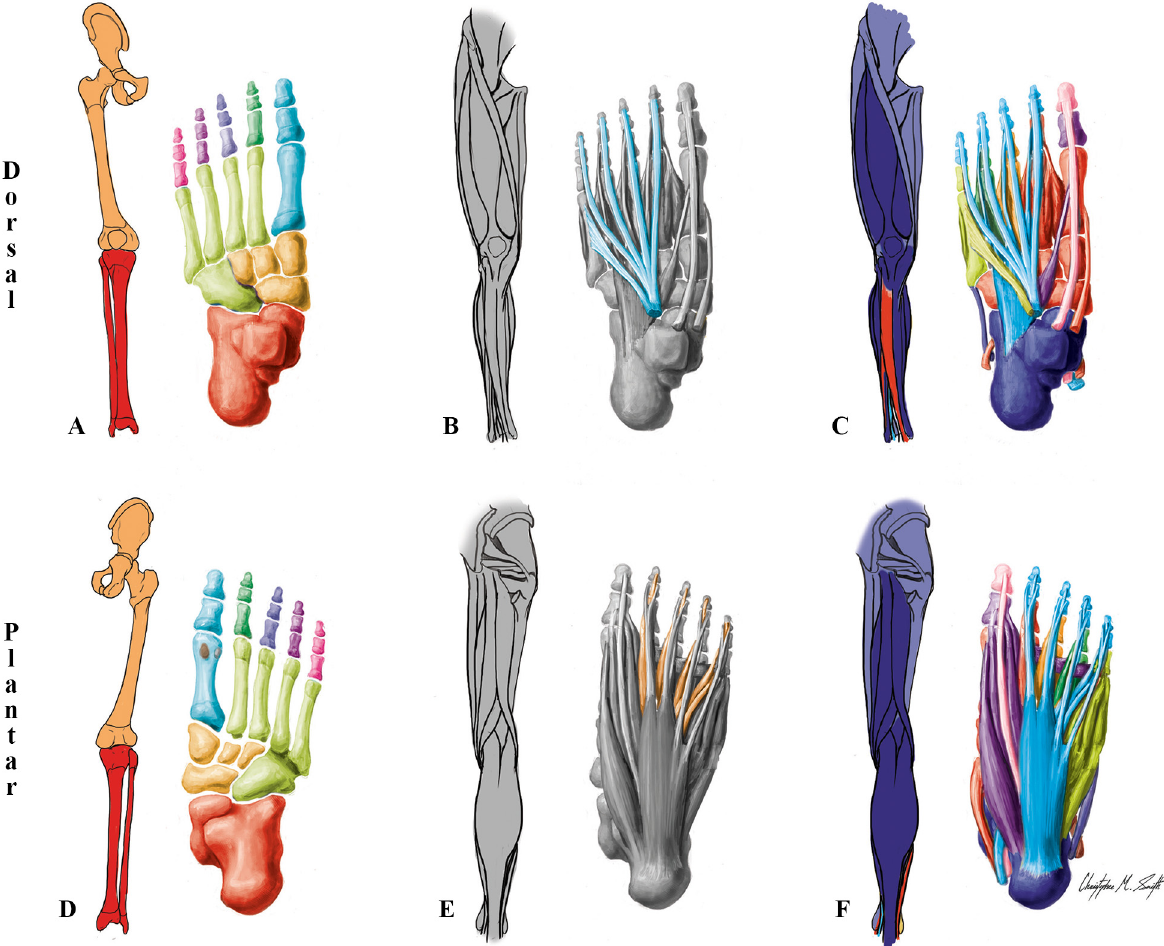
Fig 4. Modules of the normal newborn LL identified using AnNA. A to C dorsal (extensor) view; D to F ventral (flexor) view. It should be noted that the skeletal, muscular and musculoskeletal networks and modules of this left normal newborn LL are similar to the right one. A, D) Skeletal network modules: in light green , the cuboid/metarsals 2-3-4-5 module; in pink , purple , dark blue and dark green , the digit 5, 4, 3 and 2 modules; in turquoise , the digit 1/metatarsal 1 module; in red , the leg/proximal ankle module; in light orange , the tarsals module; in dark orange , the girdle/thigh module; in grey , the lateral sesamoid and medial sesamoid modules. B, E) Muscle network modules: as in normal adult (see Fig 2). C, F) Musculoskeletal network modules: in turquoise , the long flexor/extensor toes module; in red , the ankle/digit 2 movement module; in light magenta , the hip-thigh-leg movement module; in dark magenta , the leg/ankle movement module; in purple , the big toe movement module; in orange , the digit 3 movement module; in dark green , the digit 4 movement module; in light green , the digit 5 movement module; in pink , the distal phalanx digit 1 movement